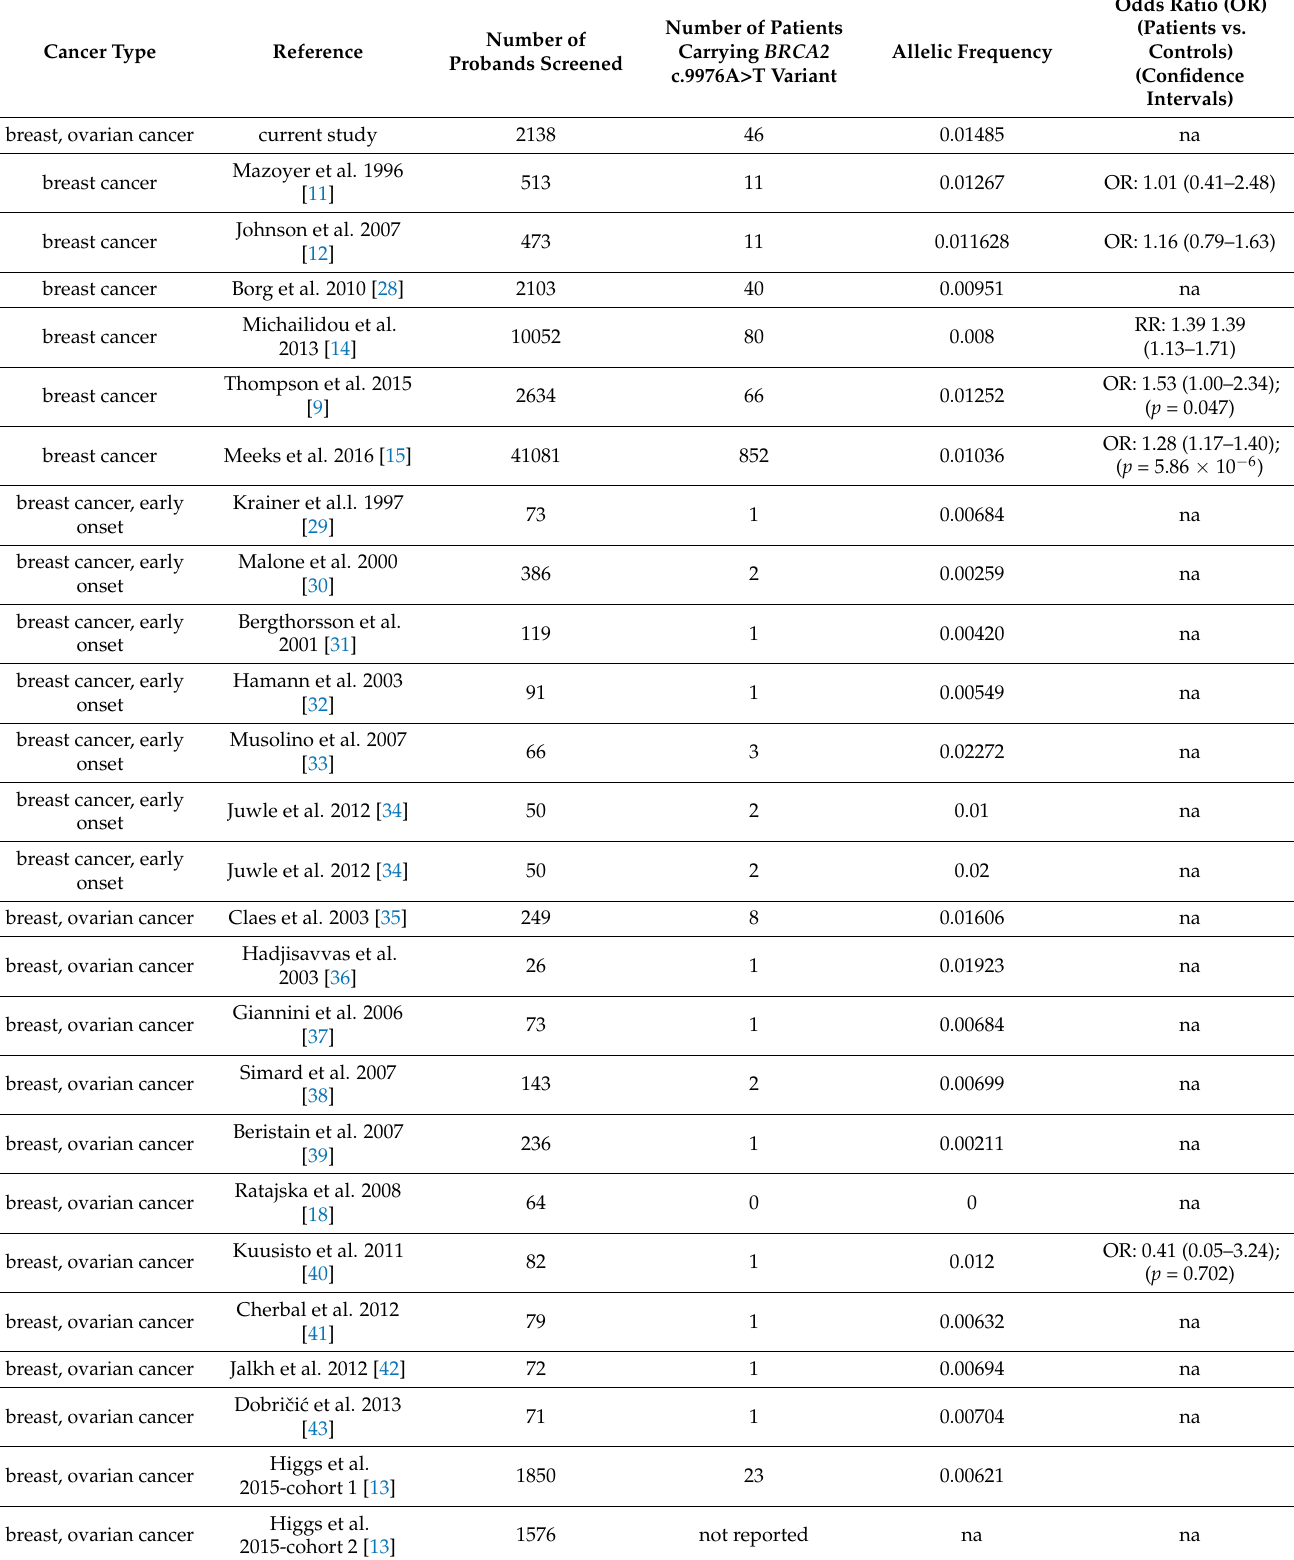
Table 4. Prevalence and association of BRCA2 c.9976A>T variant with various cancers in 38